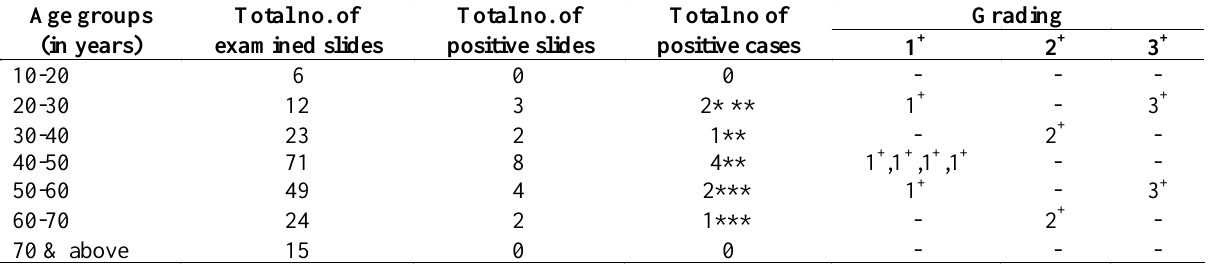
Table II : Age-wise AFB smears positivity and grading GradingAge